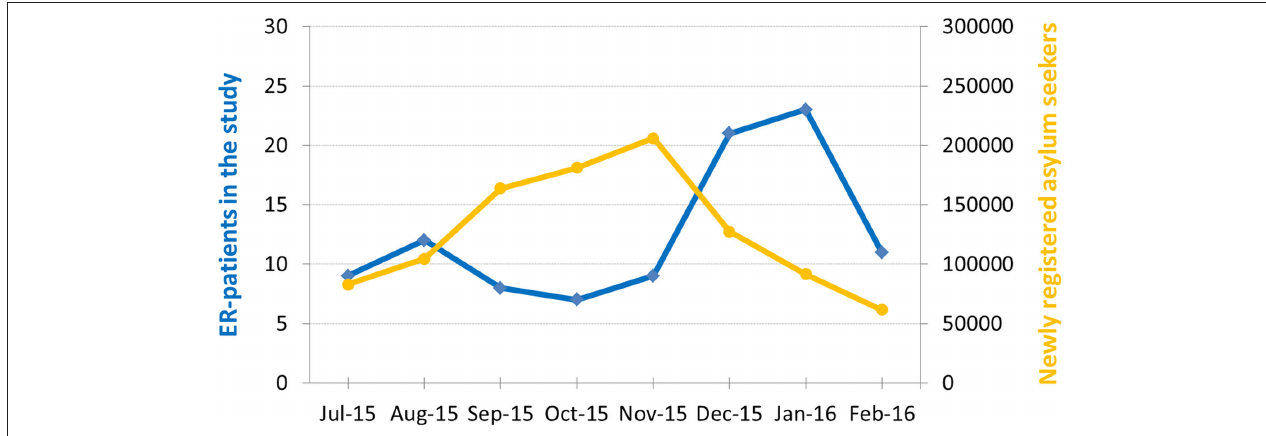
FIGURE 1 | Number of ER-patients with refugee status (blue) and number of first registrations of asylum seekers in Germany (yellow) during the recruitment period (16). Note peak of ER-patients with refugee status immediately after peak of registrations.